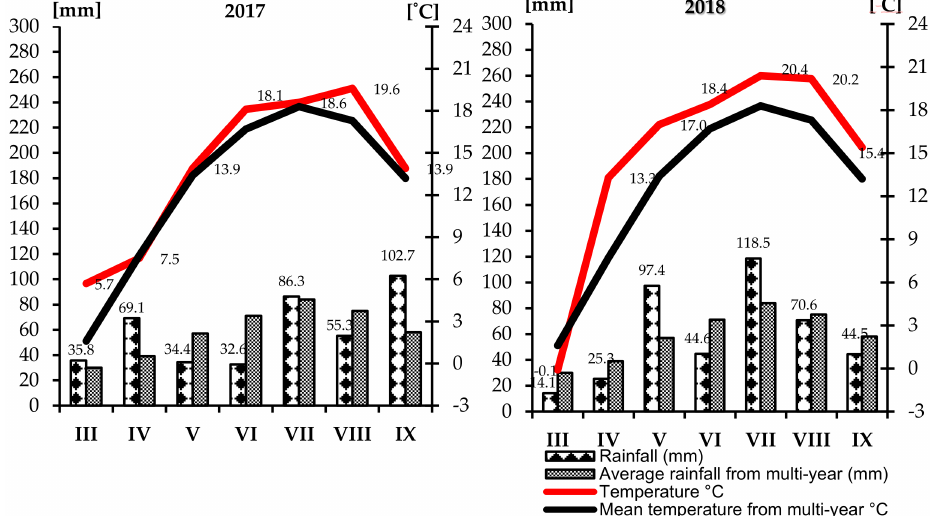
Figure 1. Monthly rainfall and temperature during the growing period in 2017 and 2018, and the long-term (1871–2000)